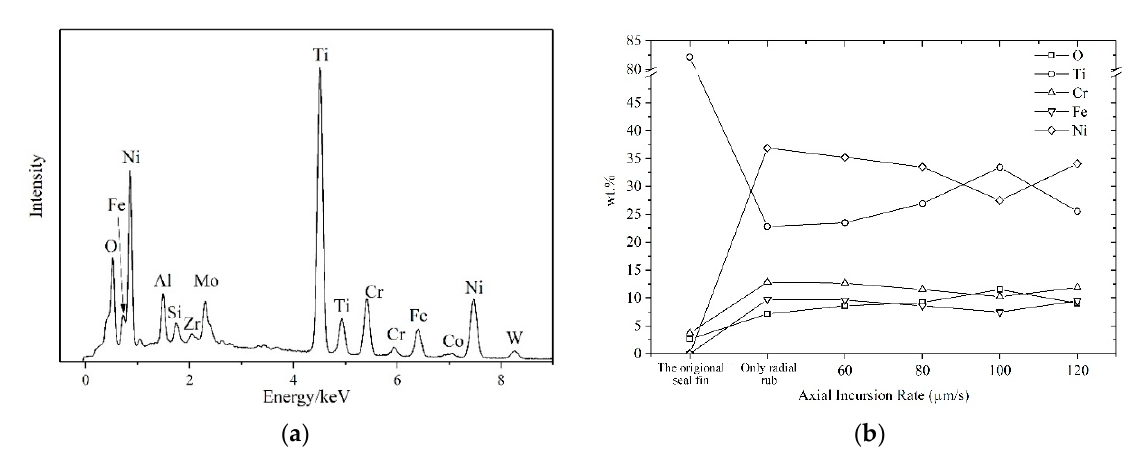
Figure 13. ( a ) The EDS spectrum at 100 μ m/s; ( b ) the weight percentage of five elements at different incursion rates.